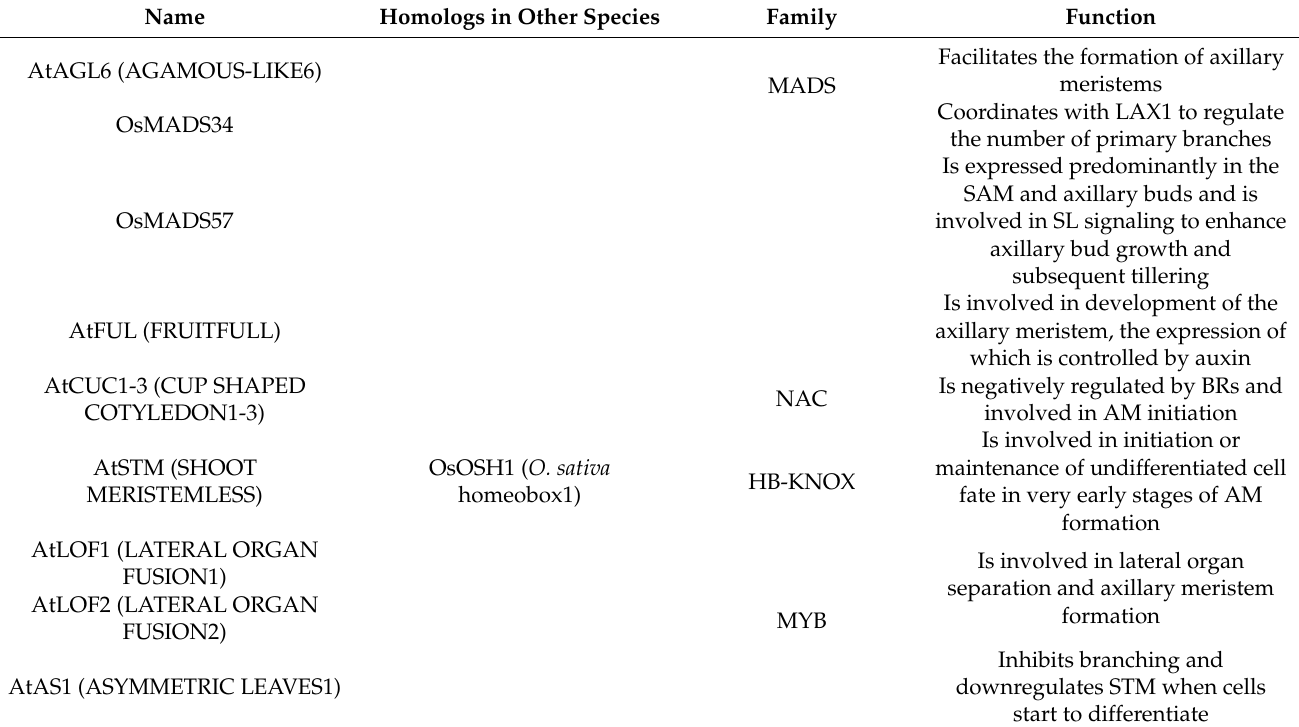
Table 1. Transcription factors involved in regulating plant branching.